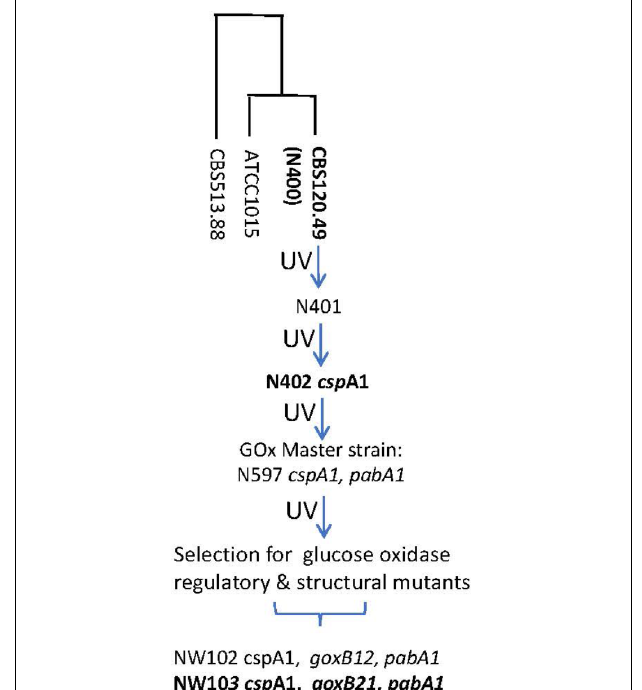
FIGURE 1 | Pedigree of glucose oxidase regulatory and structural mutants of A. niger strain N400. For strains in bold genome sequence information was obtained. N400 derived genotypes are in italics; pabA1 , p -aminobenzoic acid deficient. The “short conidiophores” cspA1 genotype was obtained after two rounds of UV mutation and selection and therefore most likely represents a complex trait. The construction of the GOx master strains have been described by Bos et al. (1988). The loci of glucose oxidase regulatory and structural mutants have been described by Swart et al. (1990). The genomes of strains CBS513.88 (Pel et al., 2007) and ATCC1015 (Andersen et al., 2011) are used for reference purposes. UV, UV